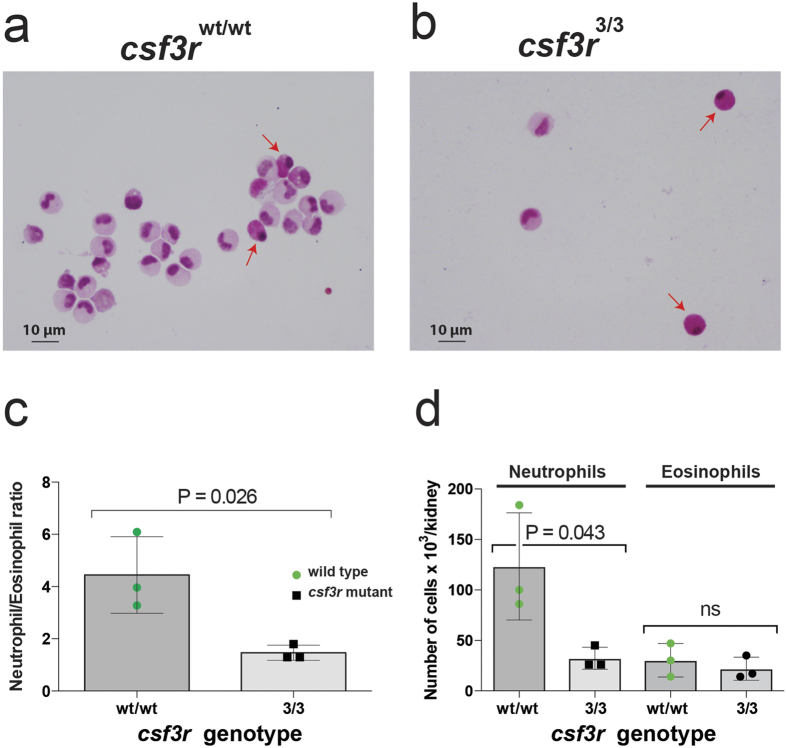
Relative preponderance of eosinophils in csf3r null kidney marrow.(a,b) Periodic Acid-Schiff (PAS) stained cytospins of FACS-purified myeloid cells from WT (a) and csf3r3/3 mutant (b) kidney marrow. Red arrows indicate eosinophils, recognised by their PAS-positive strongly pink-staining cytoplasm and nuclear morphology and position. (c) Higher Neutrophil/Eosinophil ratio in WT vs csf3r3/3 mutant myeloid cells. Individual ratios determined from >150 cell differential counts. (d) Although neutrophil numbers are depleted in csf3r−/− kidney marrow, eosinophil numbers are not, indicating that the change in neutrophil:eosinophil ratio is due to relative change in the cell population sizes.